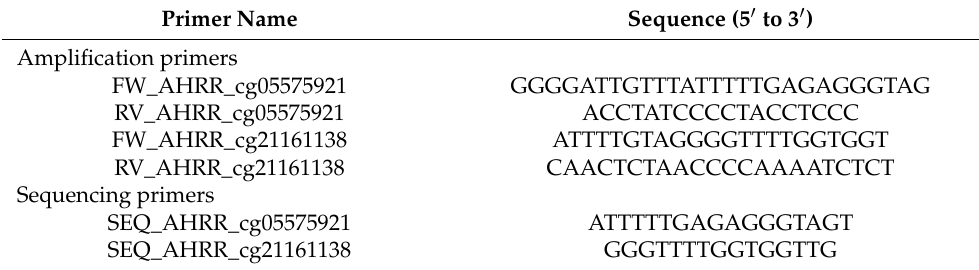
Table 3. Primers used for DNA methylation